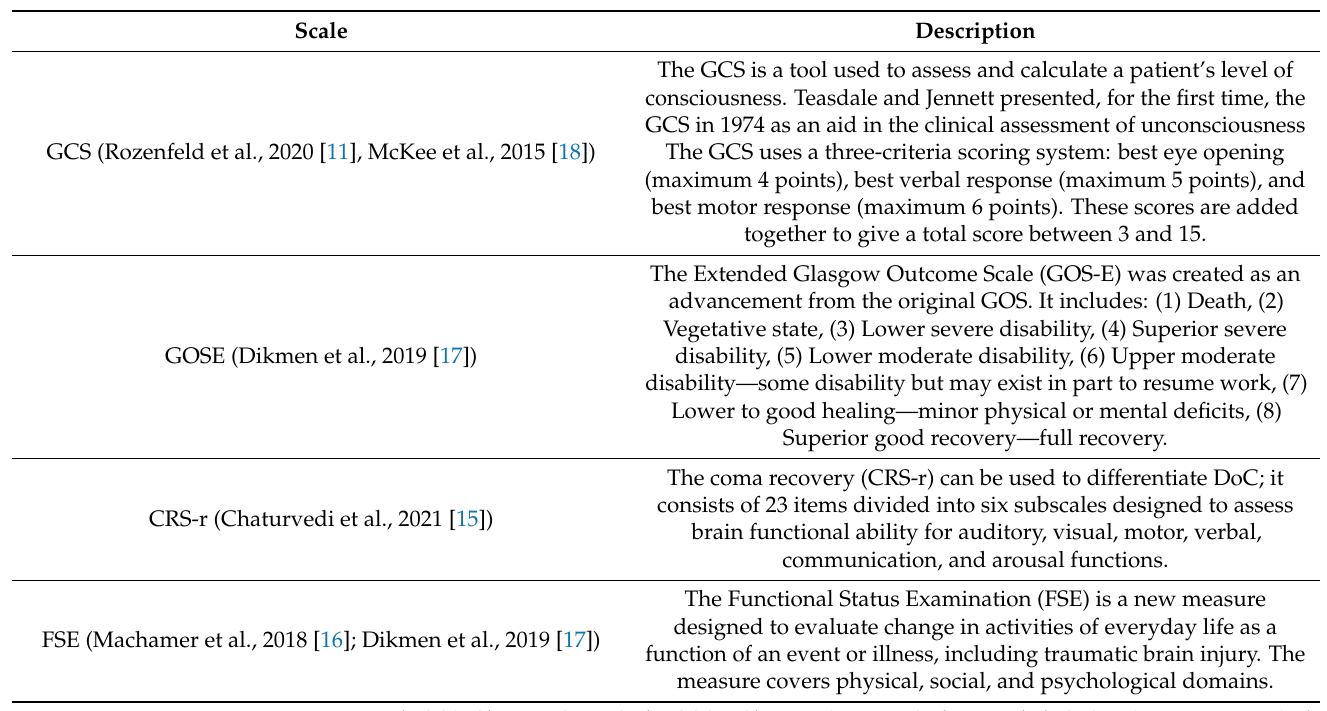
Table 2. Assessment consciousness scales to use during the vegetative state or minimally con- scious